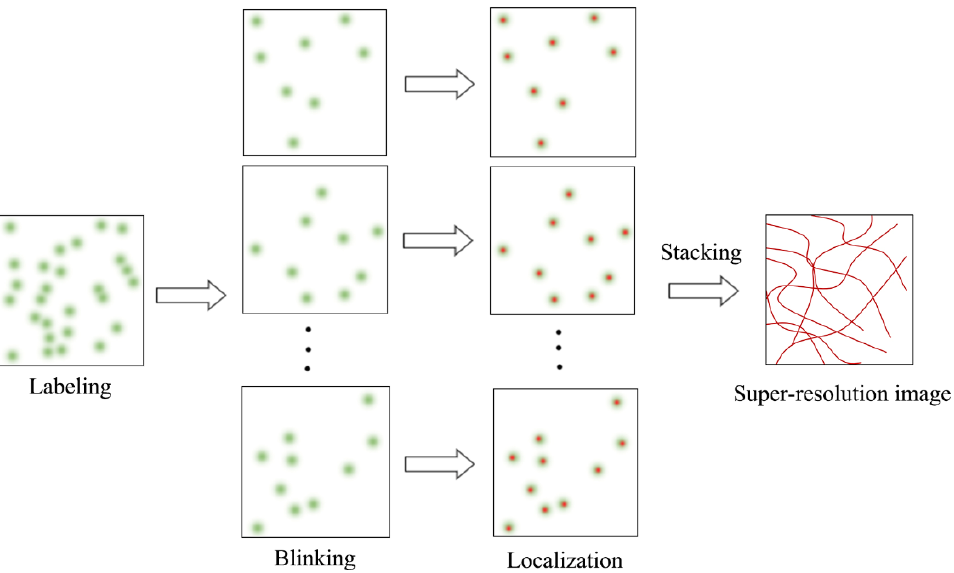
Figure 1. Schematic diagram of SMLM